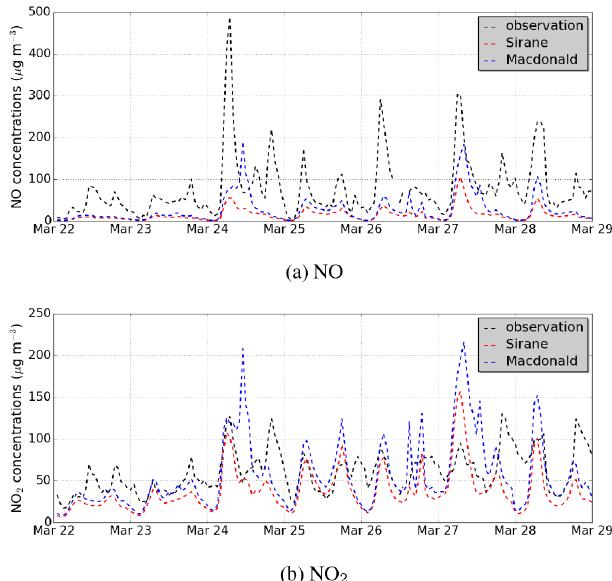
Figure 7. Comparison of observations to (a) NO and (b) NO 2 hourly concentrations (in µgm − 3 ) obtained using two different pa- rameterisations to compute the wind velocity at the roof level: SIR- ANE (Case-1) in red and MACDONALD (Case-10) in blue.